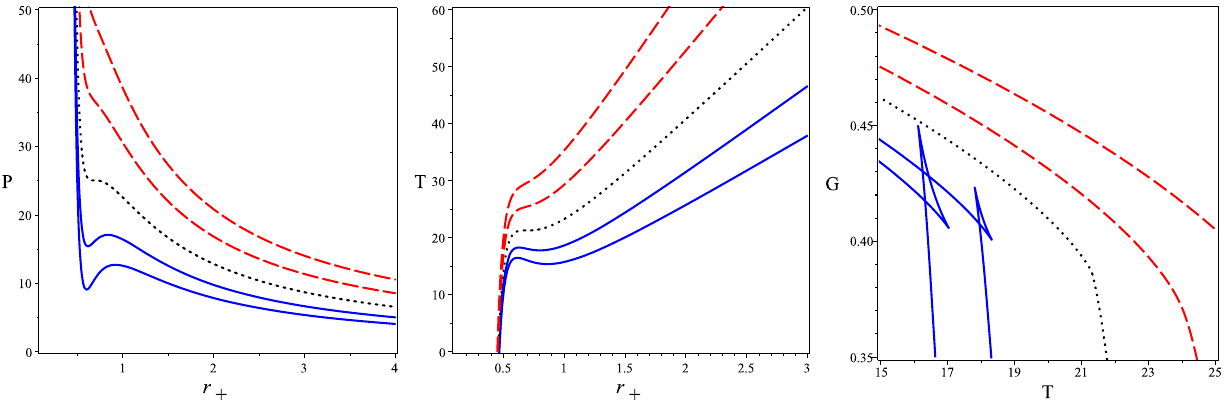
Fig. 18 LM AdS black hole with Ricci flat horizon: P − r + (left), T − r + (middle) and G − T (right) diagrams; we have set k = 0, d = 7, q = 1, m = 1 and c 0 = c 1 = c 2 = c 3 = c 4 = 1. Left panel: T < T c